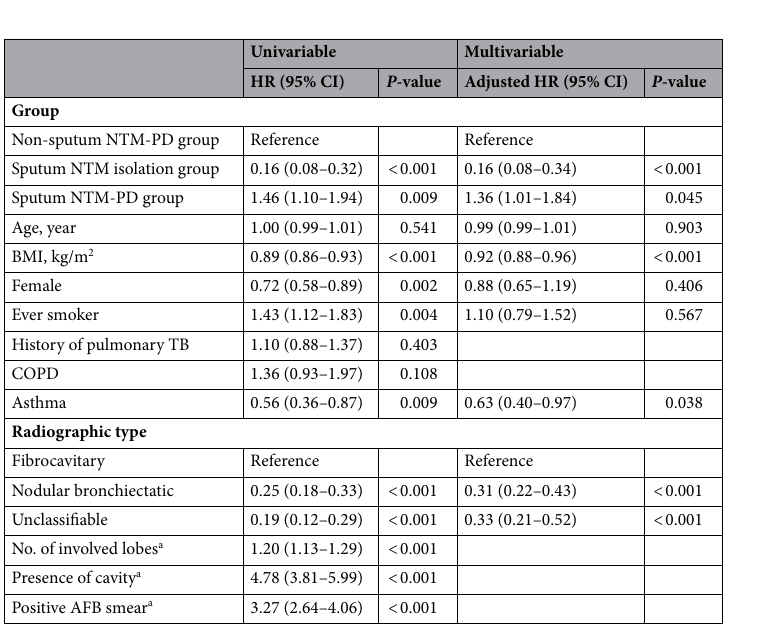
Table 3. Results of Cox proportional hazards analysis for initiation of treatment. BMI body mass index, COPD chronic obstructive pulmonary disease, GERD gastroesophageal reflux disease, NTM nontuberculous mycobacteria, NTM-PD nontuberculous mycobacterial pulmonary disease, TB tuberculosis. a Not included in multivariable analysis owing to multicollinearity with Group